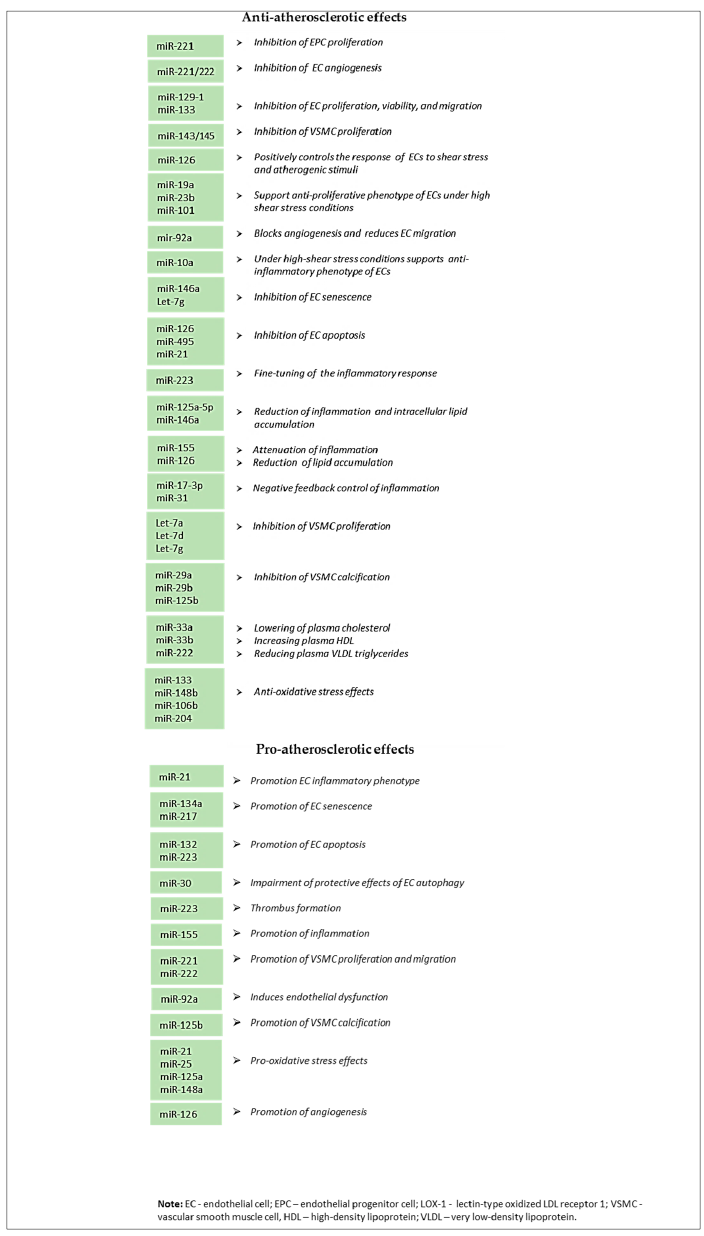
Figure 2. Summary of anti-atherosclerotic and pro-atherosclerotic effects of miRNAs.